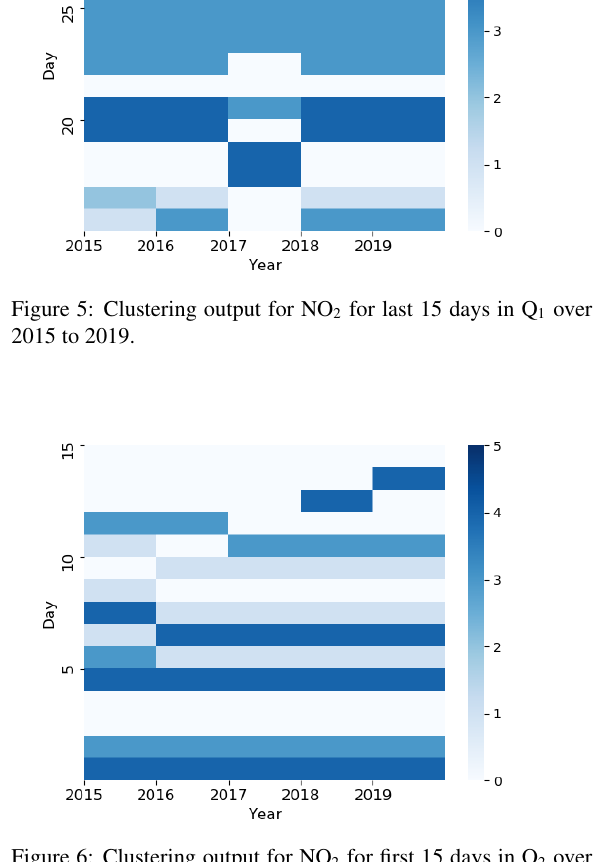
Figure 6: Clustering output for NO 2 for first 15 days in Q 2 over 2015 to